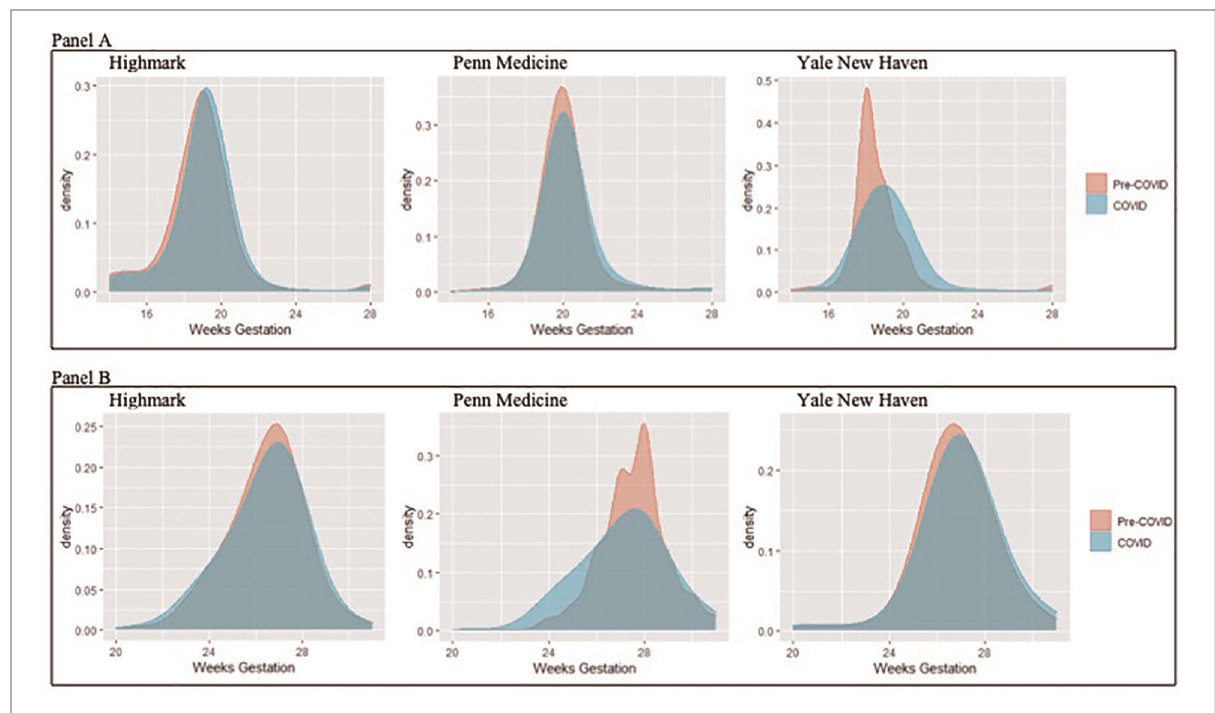
FIGURE 1 Distribution of completion of second trimester testing with an ultrasound to assess fetal anatomy (panel A ) and gestational diabetes (panel B ) across the three data sources.